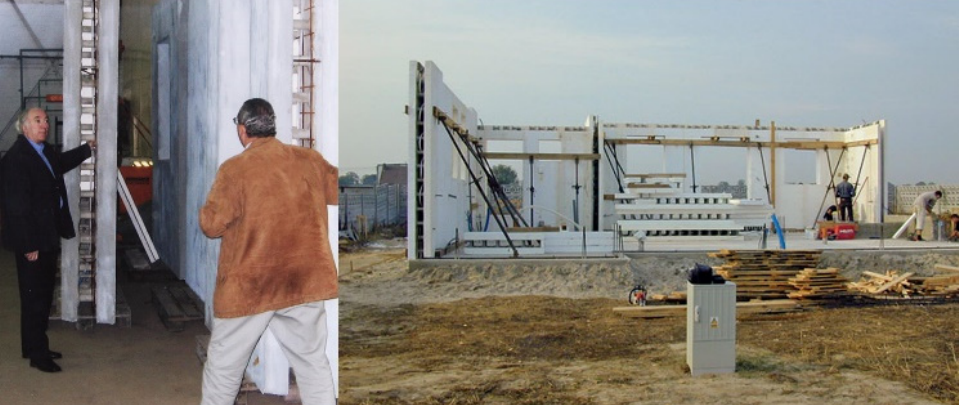
Figure 16. Construction with patented ISOMAX panels [2].